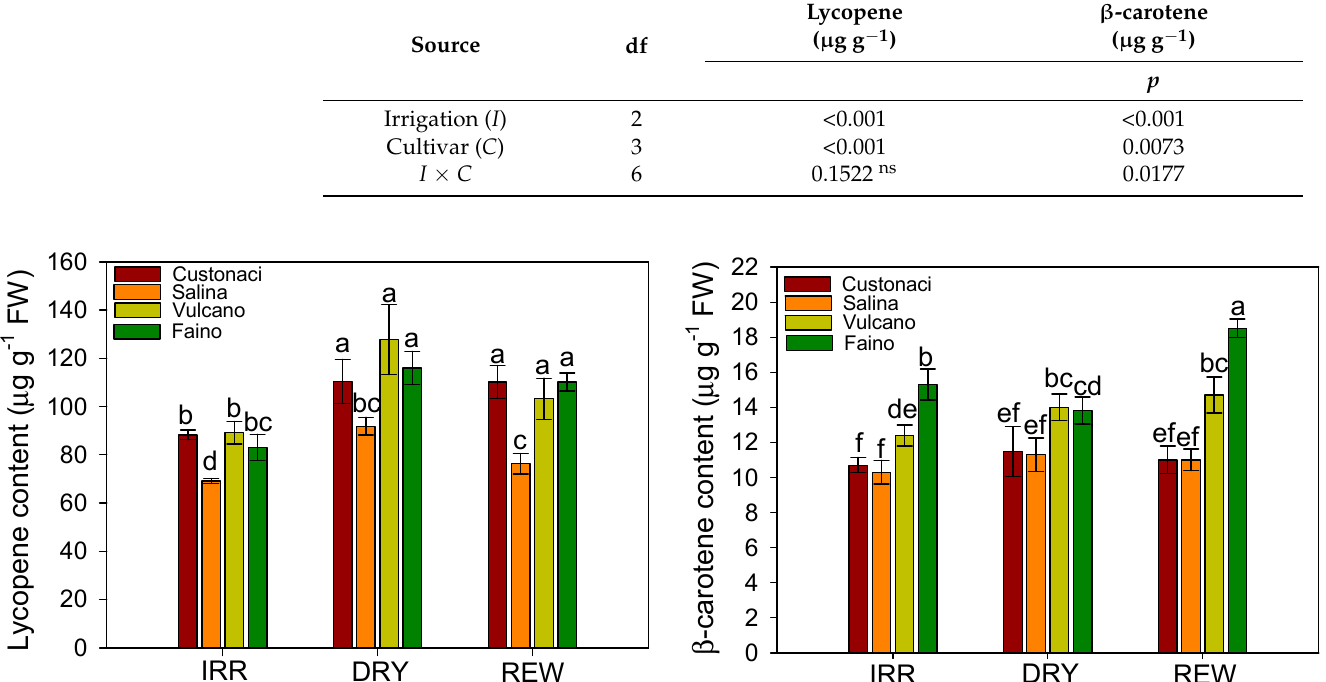
Figure 6. Lycopene ( left ) and β -carotene ( right ) content in fruits of four cultivars of tomato in response to irrigation (IRR: full irrigation; DRY: no irrigation; REW: rewatering). Bars are mean value ± standard error ( n = 3). Different letters among cultivars across irrigation treatments indicate significance at p ≤ 0.05 by Tukey’s test.